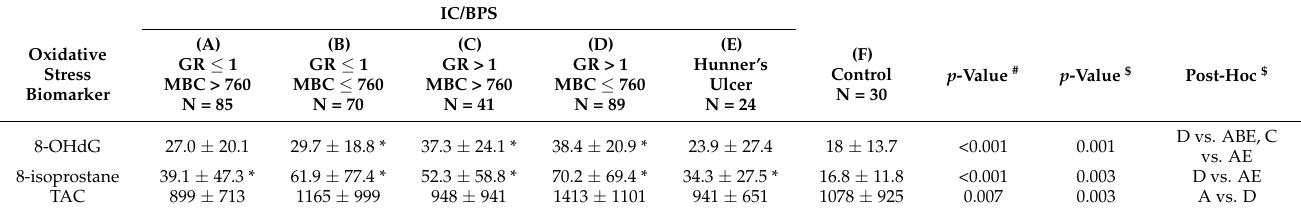
Table 6. Urinary oxidative stress biomarker levels of the different IC/BPS subgroups.